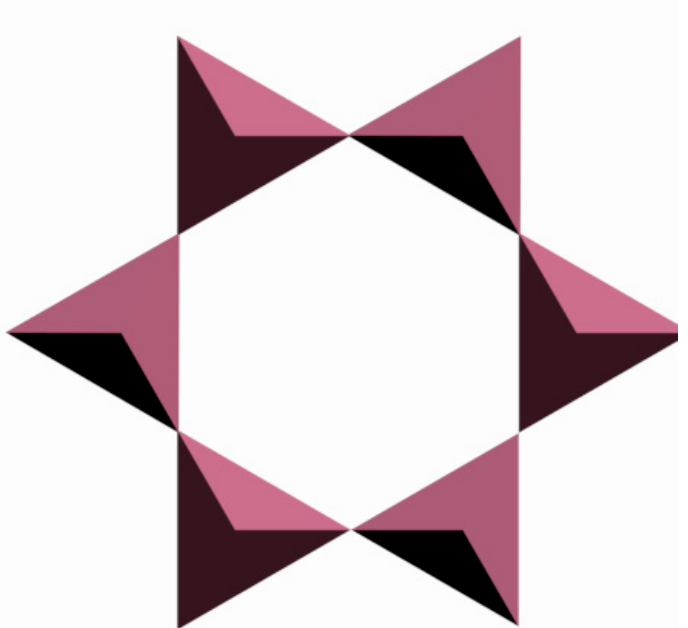
Figure 4. A six-membered ring made of TO 4 -tetrahedra (secondary building unit) [compiled by the authors].